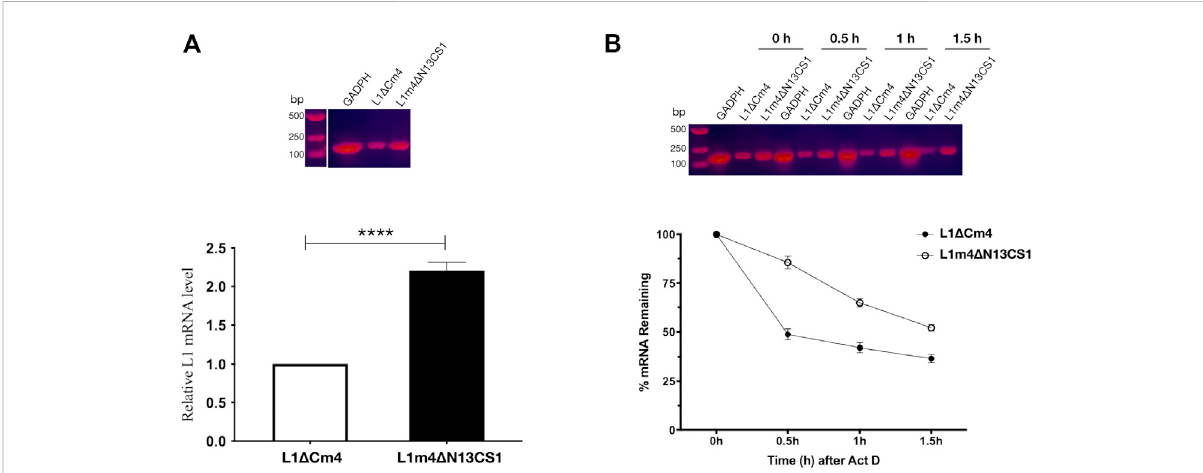
FIGURE 6 Analysis of 52L1 Δ Cm4 and 52L1m4 Δ N13CS1 mRNA levels and their stabilities by real-time PCR. (A) For mRNA level analysis, Sf9 cells infected with recombinant baculovirus containing 52L1 Δ Cm4 or 52L1m4 Δ N13CS1 genes were collected at 16 h post-infection. (B) For stability analysis, actinomycin D (ActD) (10 μ g/ml) was added to inhibit transcription at 24 h post-infection, and total RNA was respectively extracted at 0, .5, 1.0, and 1.5 h after ActD treatment. The PCR products were detected by 1% agarose gel stained with CelRed nucleic acid dye. The relative mRNA amounts were calculated using the 2 − ΔΔ CT method and normalized with internal control GAPDH . Results represent three biological repeats. Data are presented as means ± SD. The statistically signi fi cant difference (using Student ’ s t -test) is indicated by: ****, p <